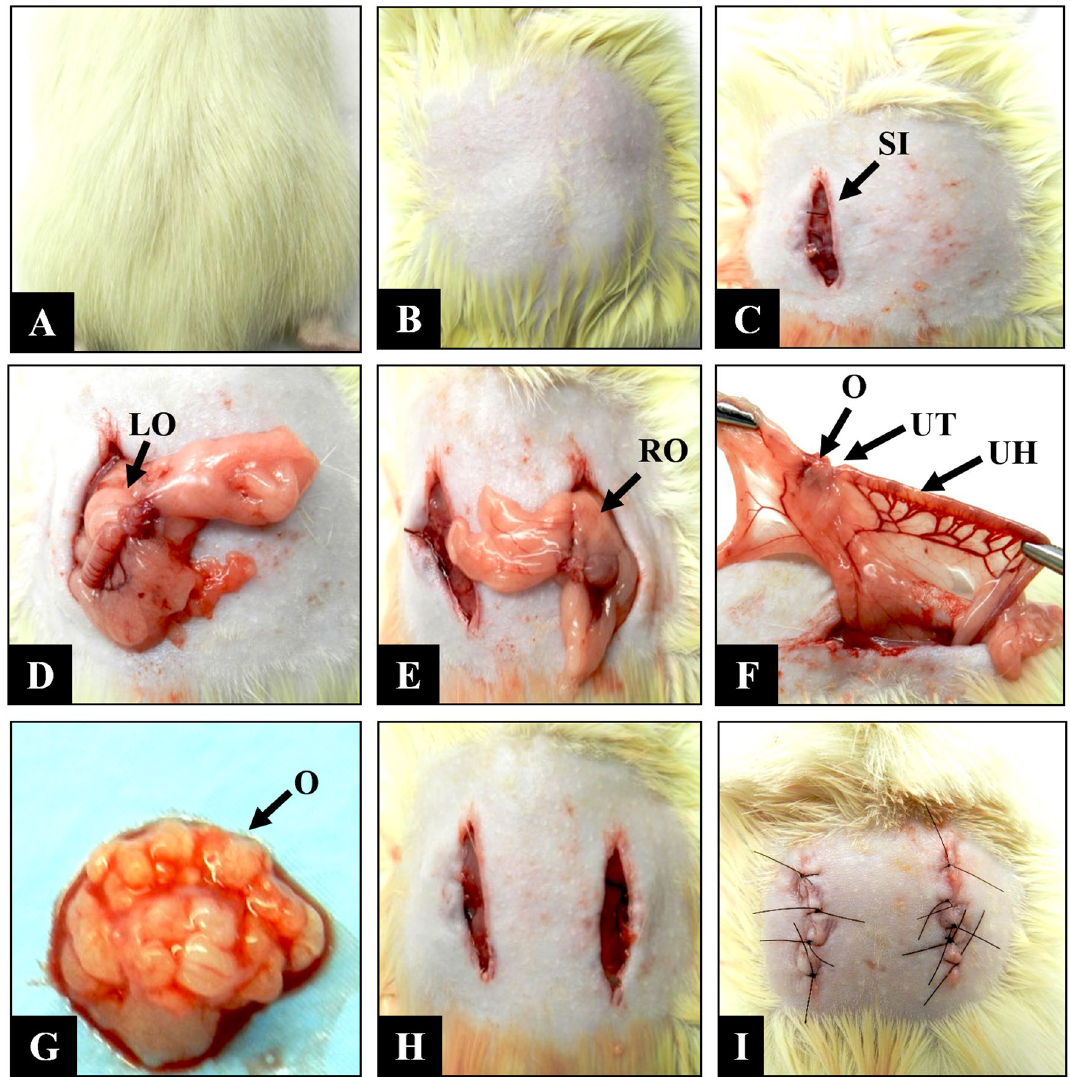
Figure 6. Ovariectomy of female Wistar rats. ( A ) Positioning of the animal in ventral decubitus. ( B ) Shaving of the lumbar region. ( C ) Longitudinal 10-mm surgical incision on the left side (SI). ( D ) Exploration of the left ovary (LO). ( E ) Contralateral posterior incision and exploration of the right ovary (RO). ( F ) Identification of the ovary ( O ), uterine tube (UT), and uterine horn (UH). ( G ) Dissection of the ovary (O). ( H ) Repositioning of the anatomical structures. ( I ) Suture of muscles and skin,